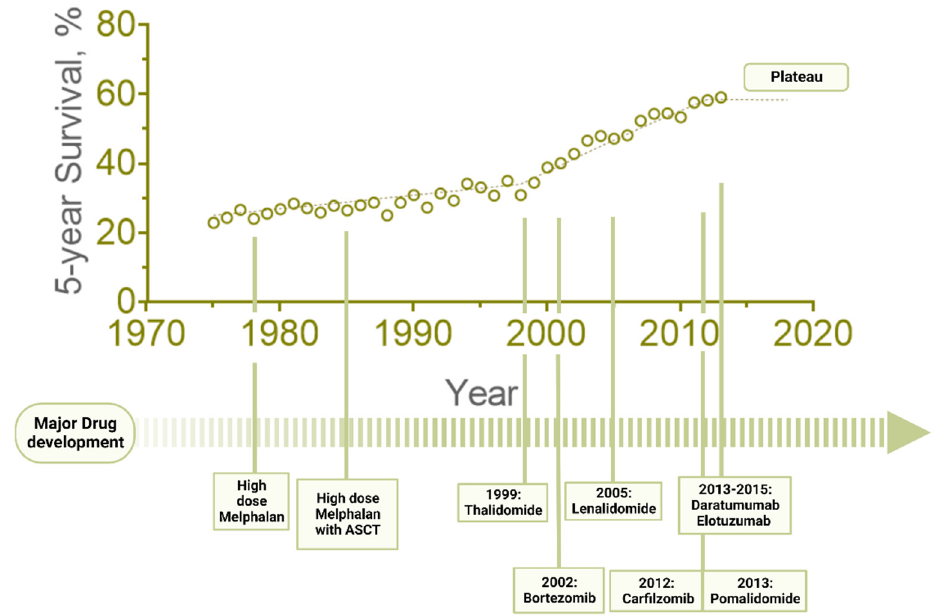
Figure 1. Five-Year Relative Survival Percent, as reported at the Surveillance, Epidemiology, and End Results (SEER) Program ( SEER Cancer Statistics Review, 1975–2018, National Cancer Institute. Bethesda, MD, USA , https://seer.cancer.gov/csr/1975_2018/ (accessed on 22 July 2022), based on Novem- ber 2020 SEER data submission, posted to the SEER web site) . The overall survival of MM dramatically